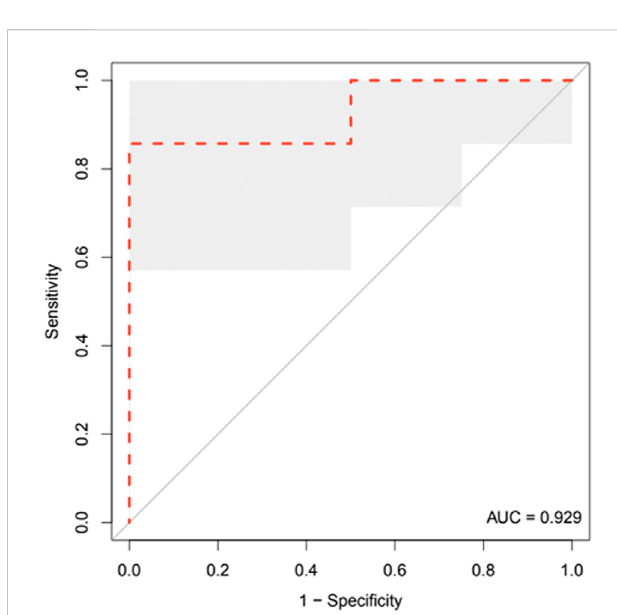
FIGURE 3 ROC curve analysis of CAIX in women who later developed the pathology ( n = 7) compared to women who did not ( n = 22) at a gestational age ranging from 28 to 32 gestational weeks. The shadowed area represents the bootstrap 95% con fi dence